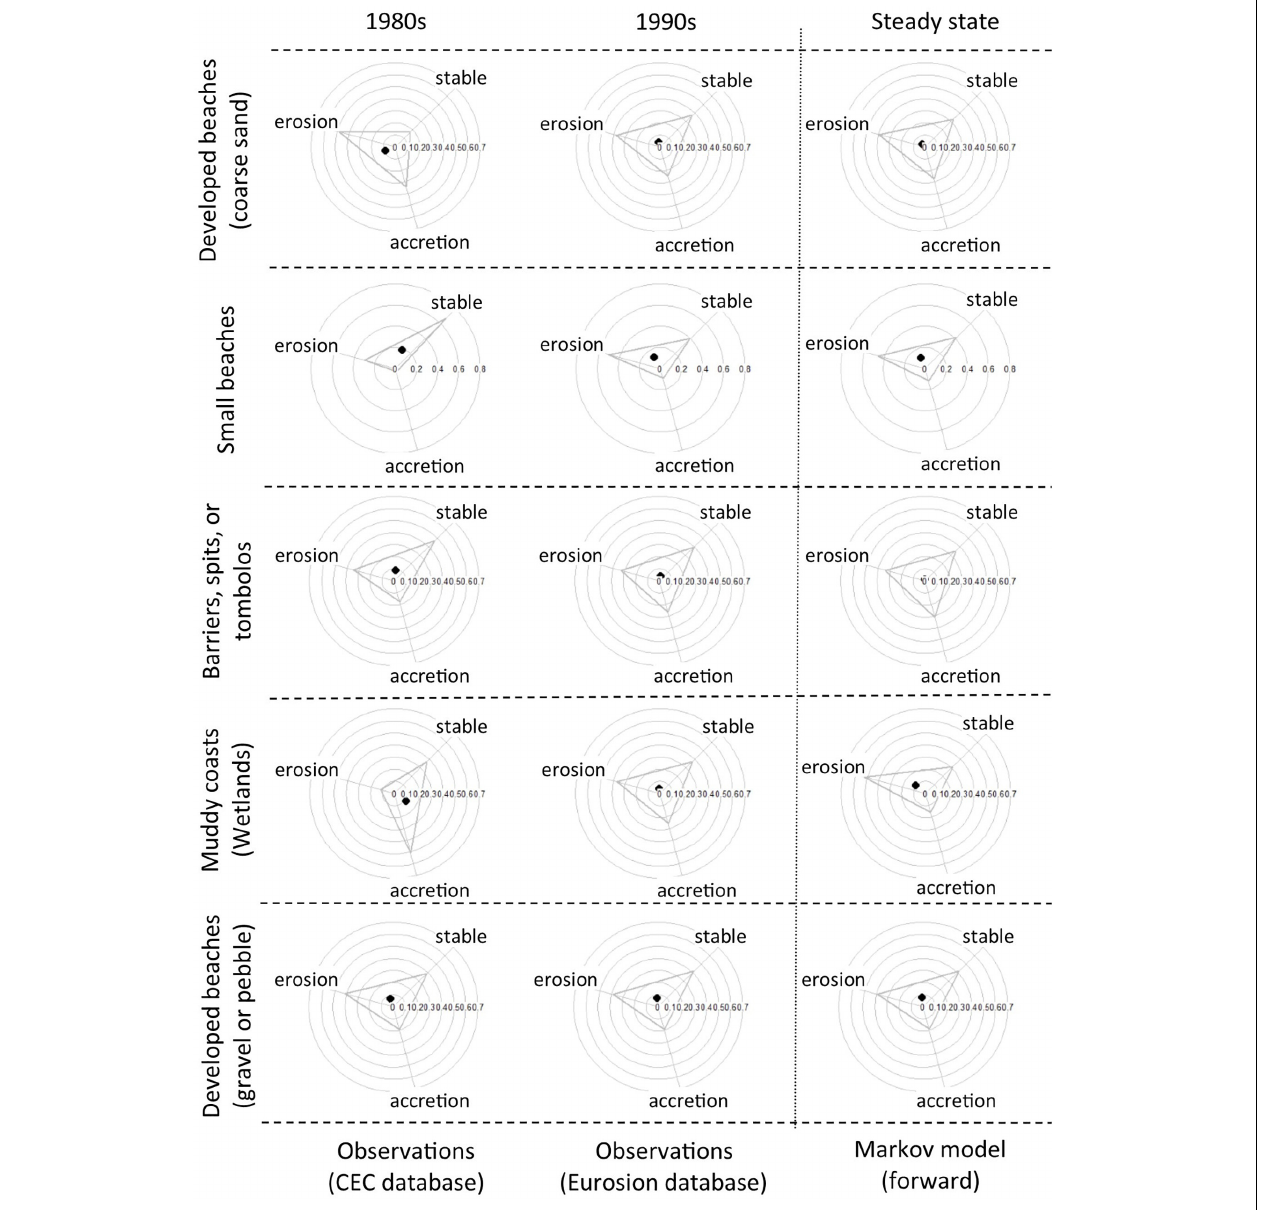
FIGURE 7 | Observed coastal evolution states and steady states obtained using a Markov chain whose parameters have been learned from observations (see number of observations in Table 2